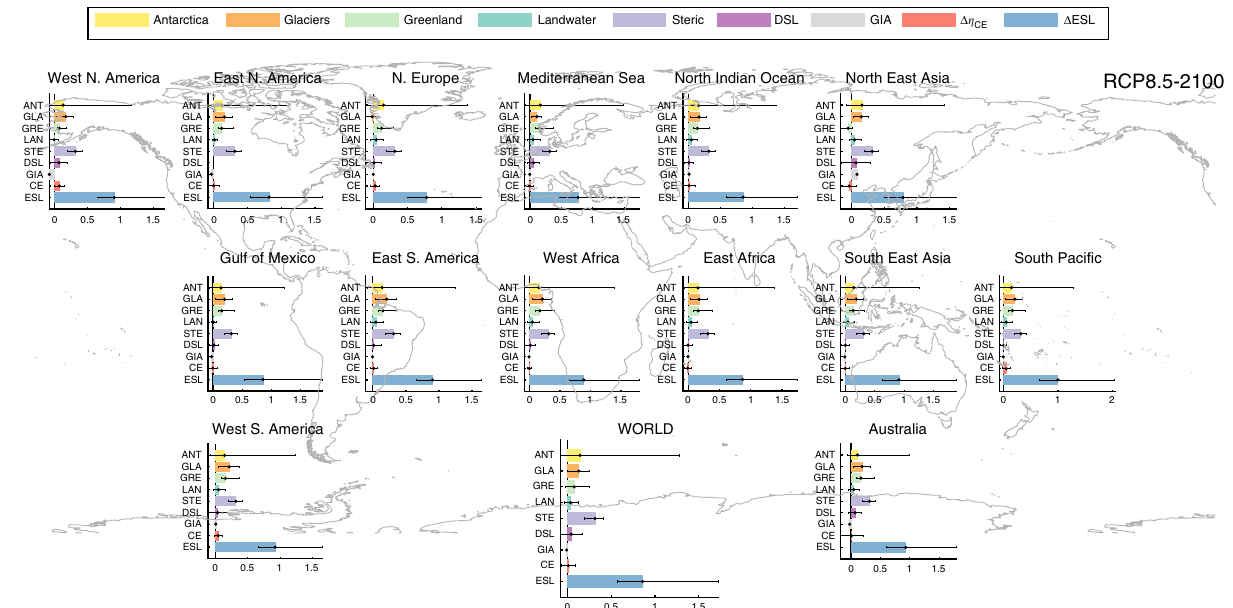
Fig. 7 Break-down of projected changes in ESL components under RCP8.5 in 2100. Projected changes in ESL contributions from Antarctica (ANT), glaciers (GLA), Greenland (GRE), land-water (LAN), steric-effects (STR), dynamic sea level (DSL), glacial isostatic adjustment (GIA), climate extremes (CE), as well as the combined 100-year ESL. Bars express the median values, black error lines the 5 and 95% quantiles. Values shown are expressed in m and re fl ect spatial averages for 14 regions and worldwide